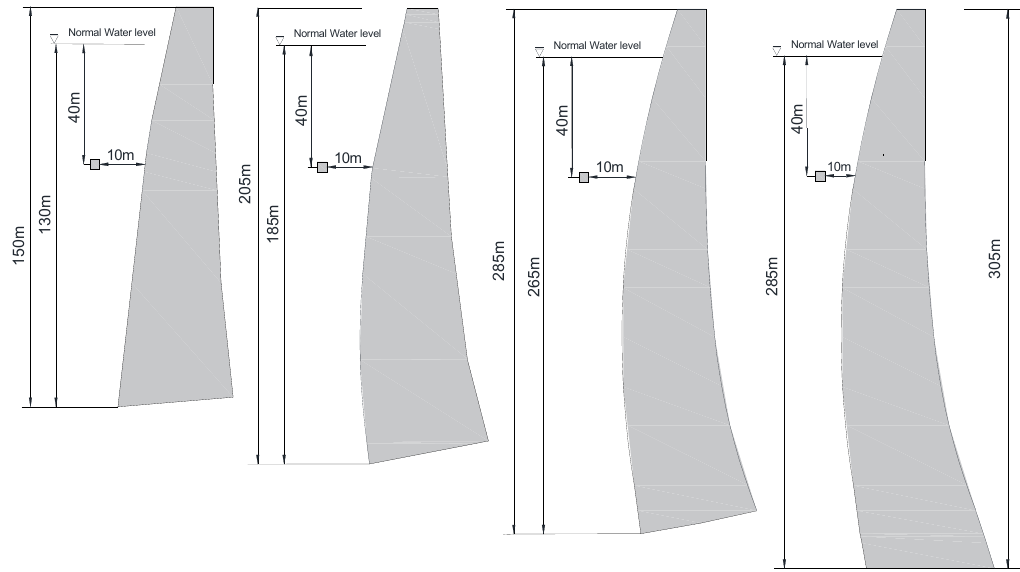
Figure 19. Positions of detonation at various levels.